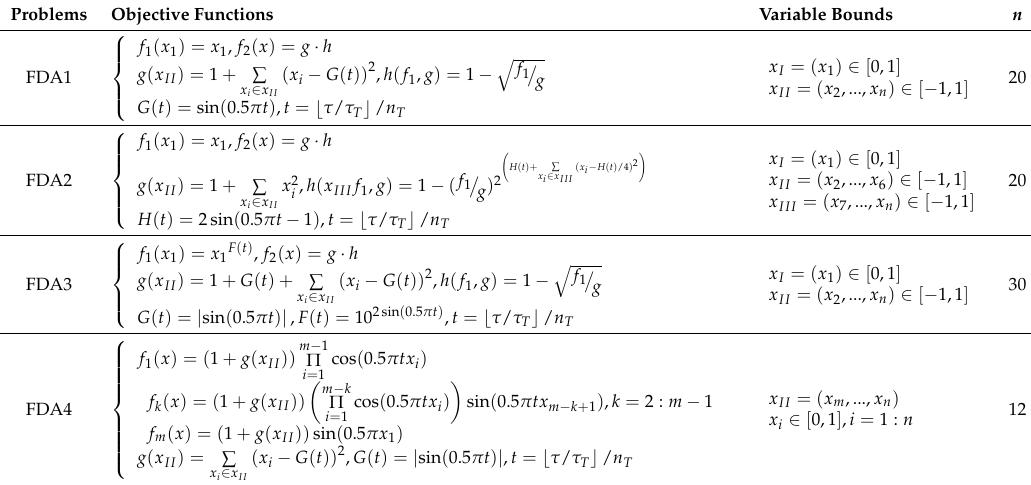
Table 1. Test problems used in our